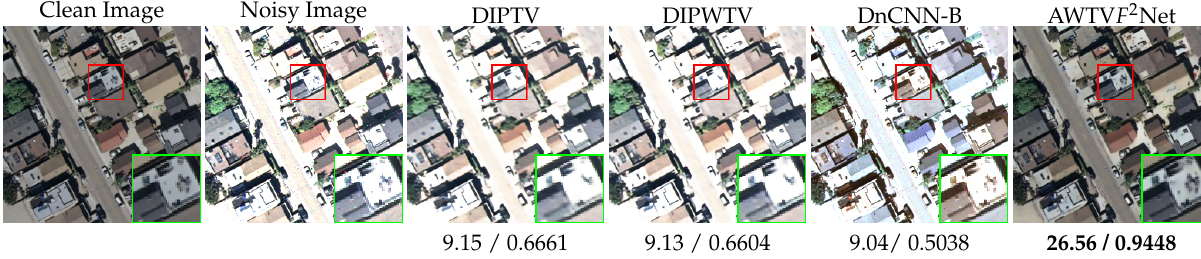
Figure 19. Detailed comparisons of the ‘Harbor’ image with the third type of mixture noise .